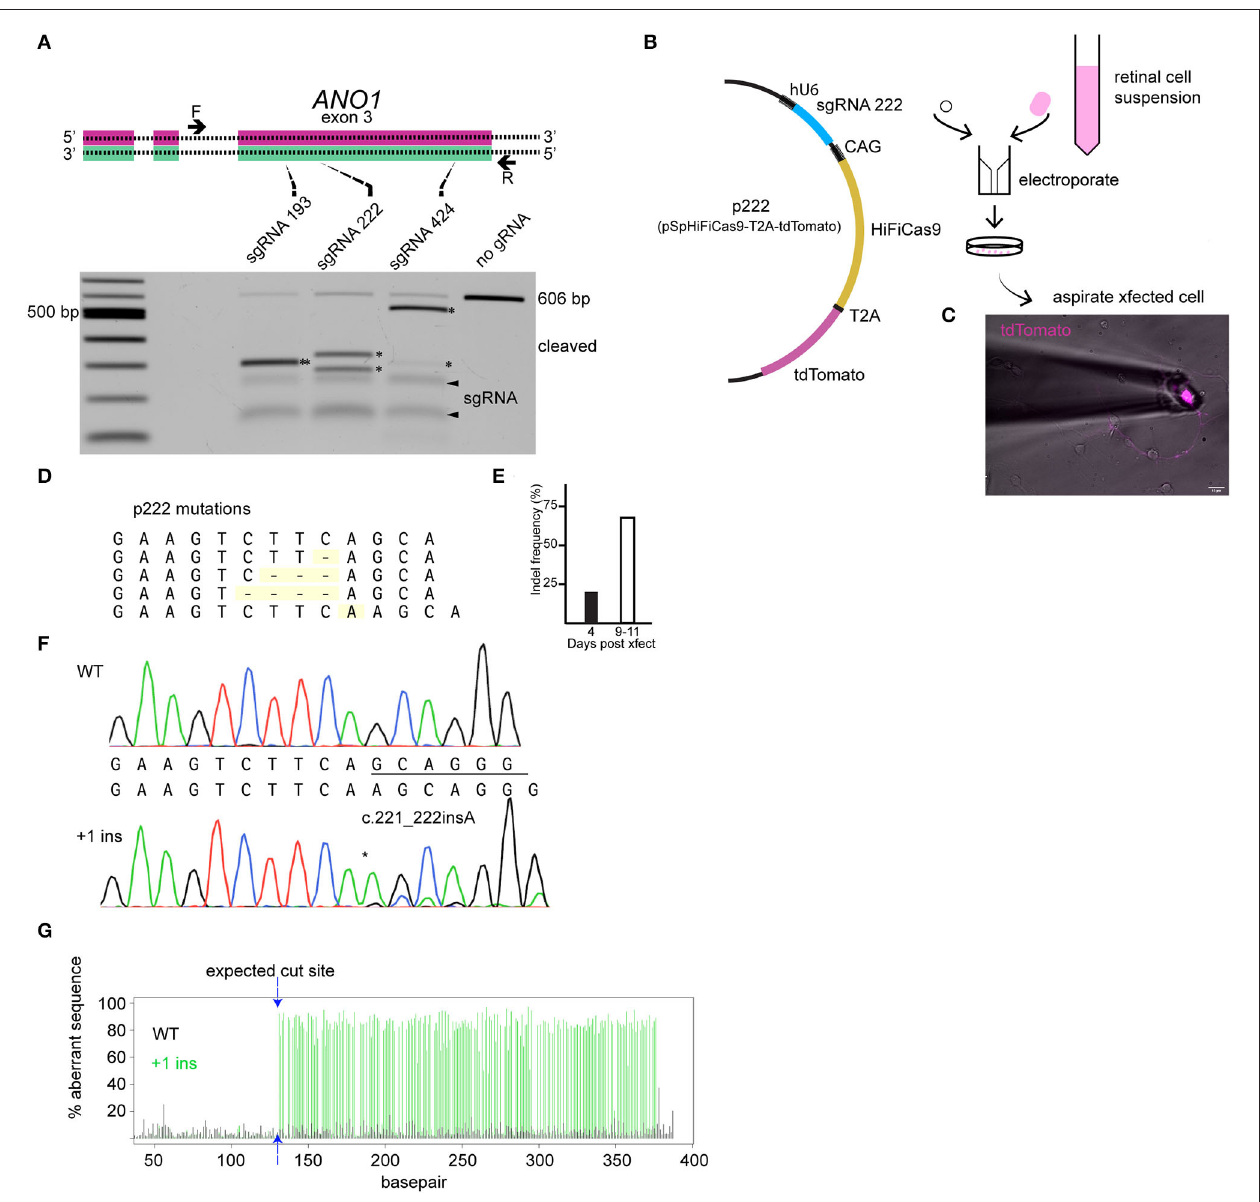
FIGURE 3 | CRISPR/Cas9 edits TMEM16A of retinal amacrine cells when delivered by an all-in-one plasmid. (A) (top) Graphical representation of target genetic loci showing the cut site for each sgRNA. Primers are denoted by the arrows, and sgRNA target regions are indicated by the dashed lines. (Bottom) Agarose gel electrophoresis of in vitro Cas9 cleaved DNA (asterisks) for each sgRNA of a 606 bp PCR product containing exon 3 of TMEM16A . The pair of faint bands below the digestion fragments correspond to sgRNA secondary structures (arrowheads). (B) Simplified plasmid map of pSpHiFiCas9-T2A-tdTomato which was electroporated into dissociated chick retinal cells. (C) AC in culture expressing tdTomato is aspirated into a glass pipette for single-cell genomic PCR. (D) List of observed mutations detected in p222 transfected cells. (E) Percent indels detected from 4 days and 9–11 days post-transfection. (F) Representative sequence traces from genomic PCR of a wild-type cell (wt/wt) and an edited cell with ∼ 30% WT and 70% + 1 insertion alleles (wt/c221_222insA) according to TIDE. (G) TIDE output from cell in (F) shows substantial aberrant sequence starting at the expected cut site due to a mixture of WT and + 1 amplicons in the edited cells PCR. * indicates cleavage products.